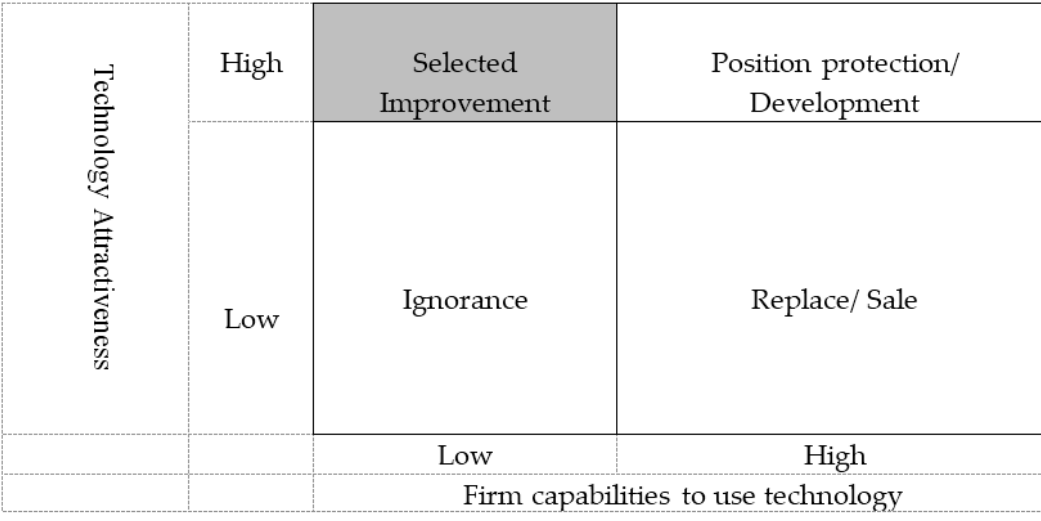
Figure 1. Technology portfolio analysis.